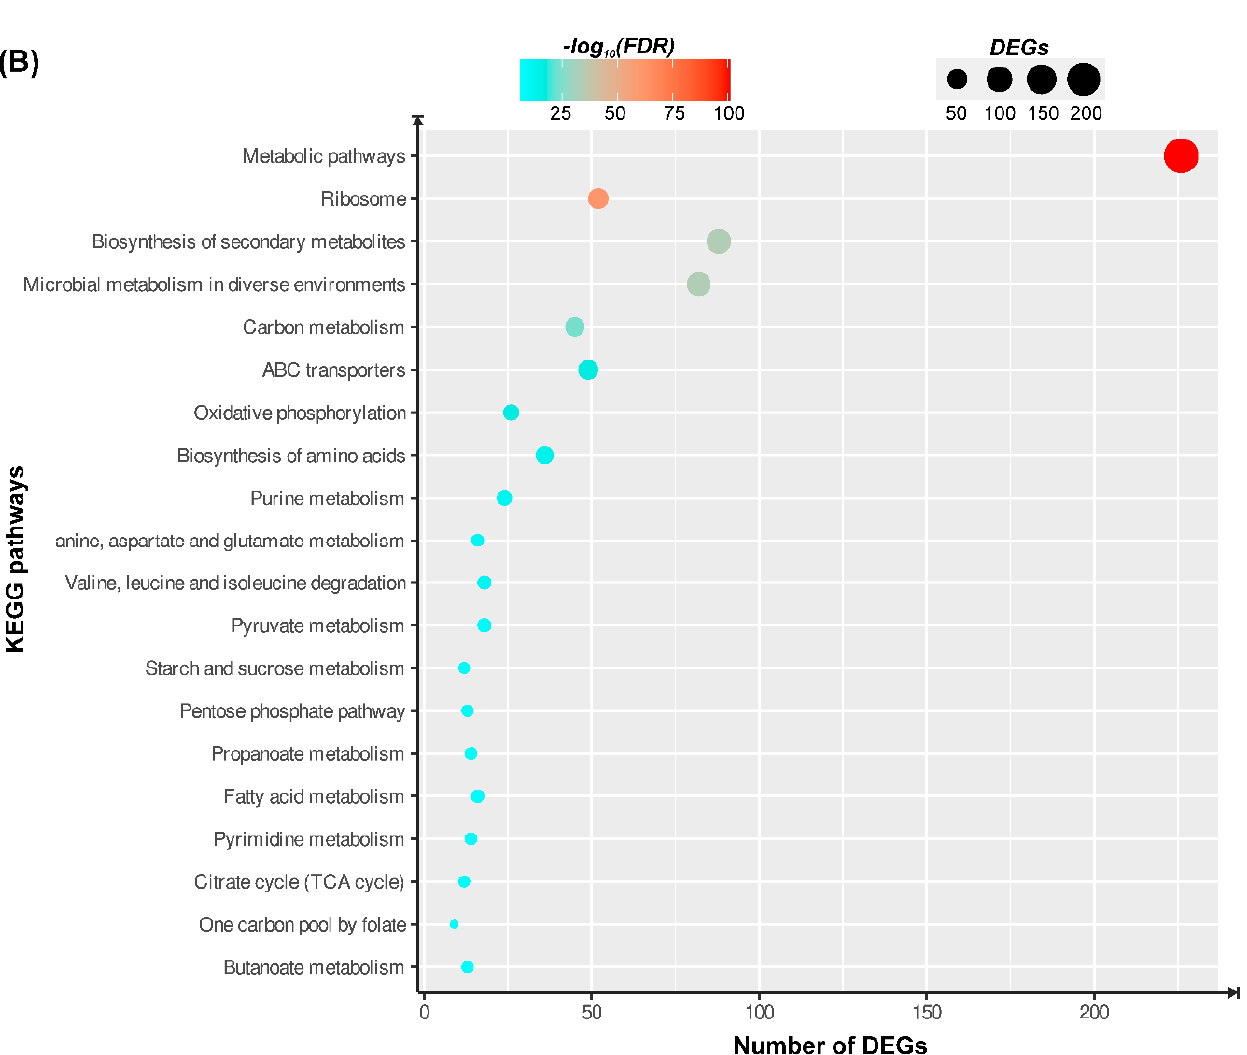
Figure 7. Enrichment analyses of Pseudomonas sp. J380 DEGs under iron-limitation. ( A ) Results from Gene Ontology (GO) enrichment analysis performed using ShinyGO illustrating twenty most significantly ( p < 0.05) enriched GO terms under molecular function (MF), cellular component (CC), and biological process (BP) categories. ( B ) Results from KEGG (Kyoto Encyclopedia of Genes and Genomes) pathway enrichment analysis performed using KEGG database illustrating twenty most significantly ( p < 0.05) enriched pathways. All the adjusted statistically significant values of GO terms or KEGG pathways were negative log 10 -transformed. For complete lists of enriched GO terms and KEGG pathways, refer to Tables S6 and S7).